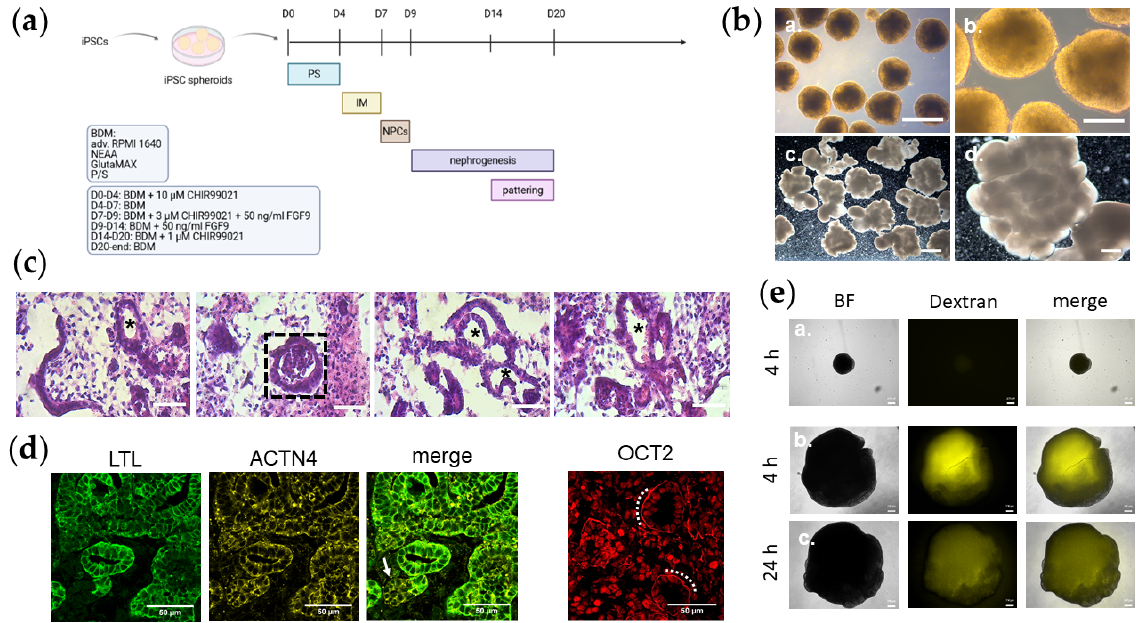
Figure 1. Lobular kidney organoids contain distinct kidney structures. ( a ) Schematic depiction of the protocol for generating kidney organoids. ( b ) Overview of iPSC spheroids at D8 after generation (a.,b.) and kidney organoids UMK2 at D21 (c.,d.) with binocular. (a.) 4 × magnification under light microscope. Scale bar depicts 500 µ m. (b.) 10 × magnification under light microscope. Scale bar depicts 200 µ m. (c.) 1 × magnification. Scale bar depicts 2000 µ m. (d.) 4 × magnification. Scale bar depicts 2000 µ m. ( c ) Morphology of organoid section via histological H&E staining. A typical glomerulus-like structure is depicted by a dashed rectangle. Tubule-like structures are marked with an asterisk. Scale bar depicts 50 µ m. ( d ) Confocal pictures of glomerular (ACTN4, yellow) and tubular (LTL, green) structures in UMK1 sections. Nuclear OCT2 ( POU2F2 ) (red) is expressed in UMK1 sections. A glomerulus-like structure was marked with an arrow. Scale bar depicts 50 µ m. ( e ) Monitoring of iPSC spheroids and kidney organoids in a dextran uptake assay. (a.) iPSC spheroids treated with dextran after 4 h pulse. (b.) kidney organoids treated with dextran after 4 h pulse. (c.) kidney organoids treated with dextran after 24 h chase. Scale bar depicts 200 µ